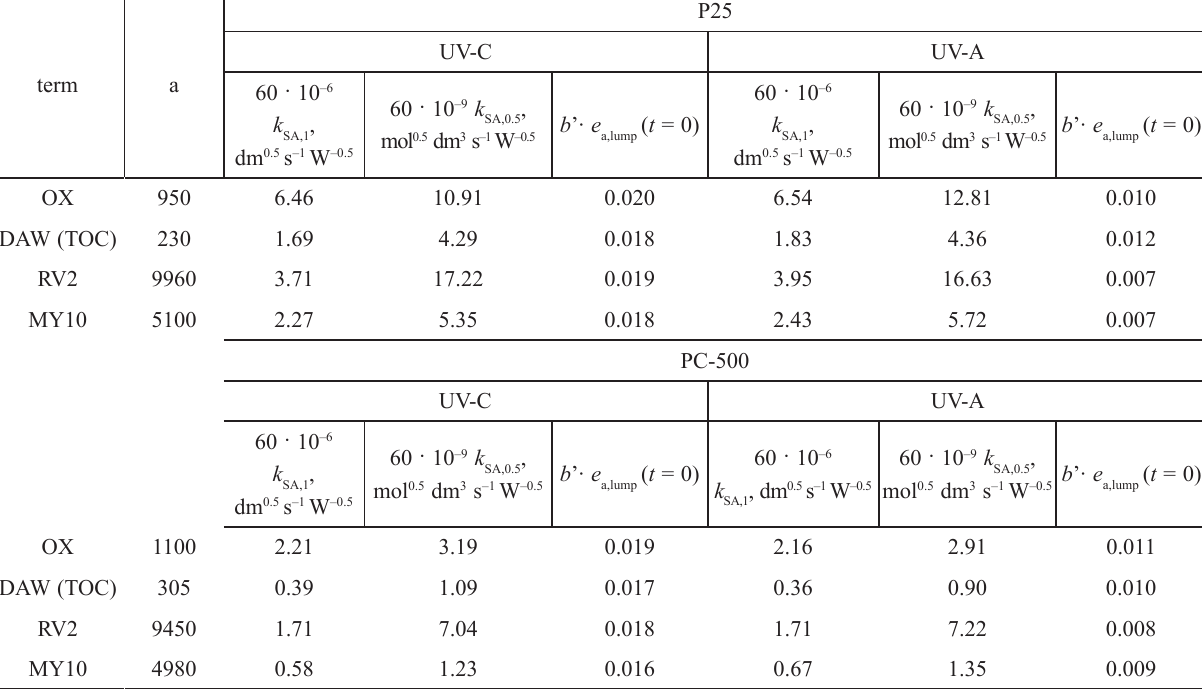
Table 2 – Evaluation of detailed kinetic study: estimated intrinsic reaction rate constants and model coefficients